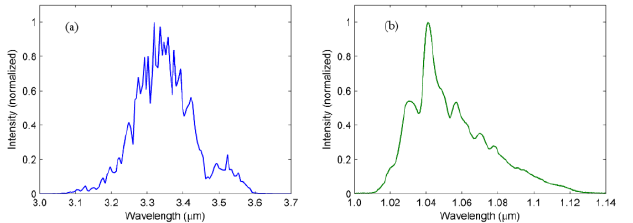
Fig. 2. Typical spectra at (a) 3.3 μm and (b) 1.04